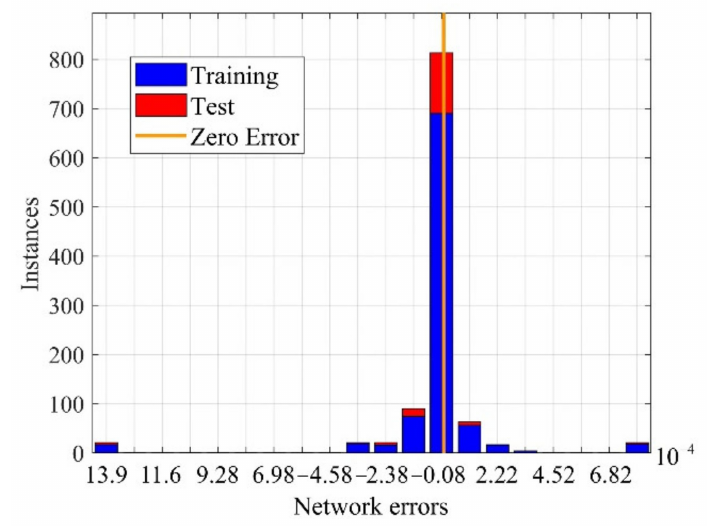
Figure 11. Error distribution of the neural network output.